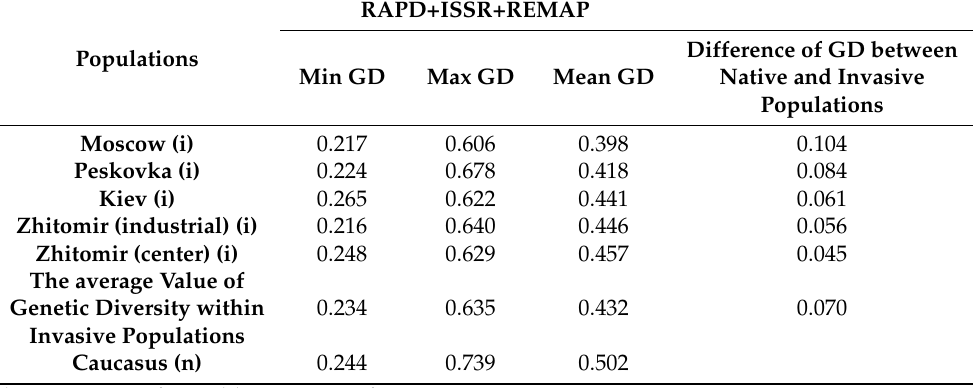
Table 6. The mean values of genetic diversity (GD), and their maximum and minimum values for H. sosnowskyi invasive and native populations obtained by combination of methods RAPD, ISSR and